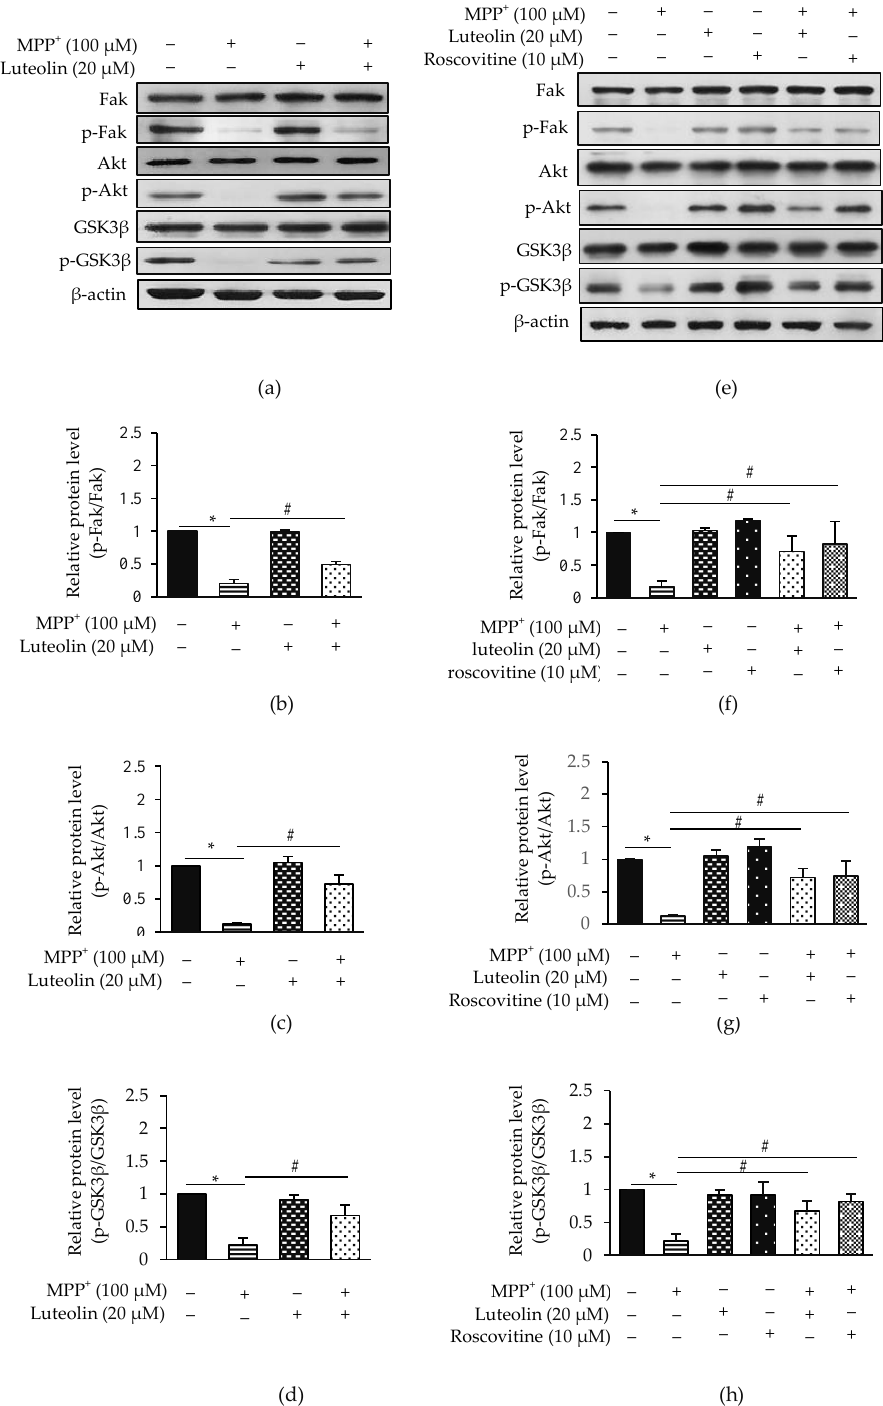
Figure 8. Luteolin ameliorated MPP + -suppressed Fak/Akt/GSK3 β in SH-SY5Y cells. Cells were pre-treated with 20 µ M luteolin for 1 h, followed by treatment with 100 µ M MPP + for 24 h. ( a ) Expressions of Fak, p-Fak, Akt, p-Akt GSK3 β and p-GSK3 β were analyzed using western blotting. Quantification of ( b ) p-Fak/Fak, ( c ) p-Akt/Akt and ( d ) p-GSK3 β /GSK3 β was shown in a bar graph. Cells were pre-treated with 20 µ M luteolin and 10 µ M roscovitine for 1 h, followed by treatment with 100 µ M MPP + for 24 h. ( e ) Expressions of Fak, p-Fak, Akt, p-Akt GSK3 β and p-GSK3 β were analyzed by western blotting. Quantification of ( f ) p-Fak/Fak, ( g ) p-Akt/Akt and ( h ) p-GSK3 β /GSK3 β was shown in the bar graph. Data were normalized using β -actin as a control. Results presented as the mean ± SD for triplicated independent experiments. Differences are statistically significant at * p < 0.05 versus the control group, and # p < 0.05 versus the MPP +